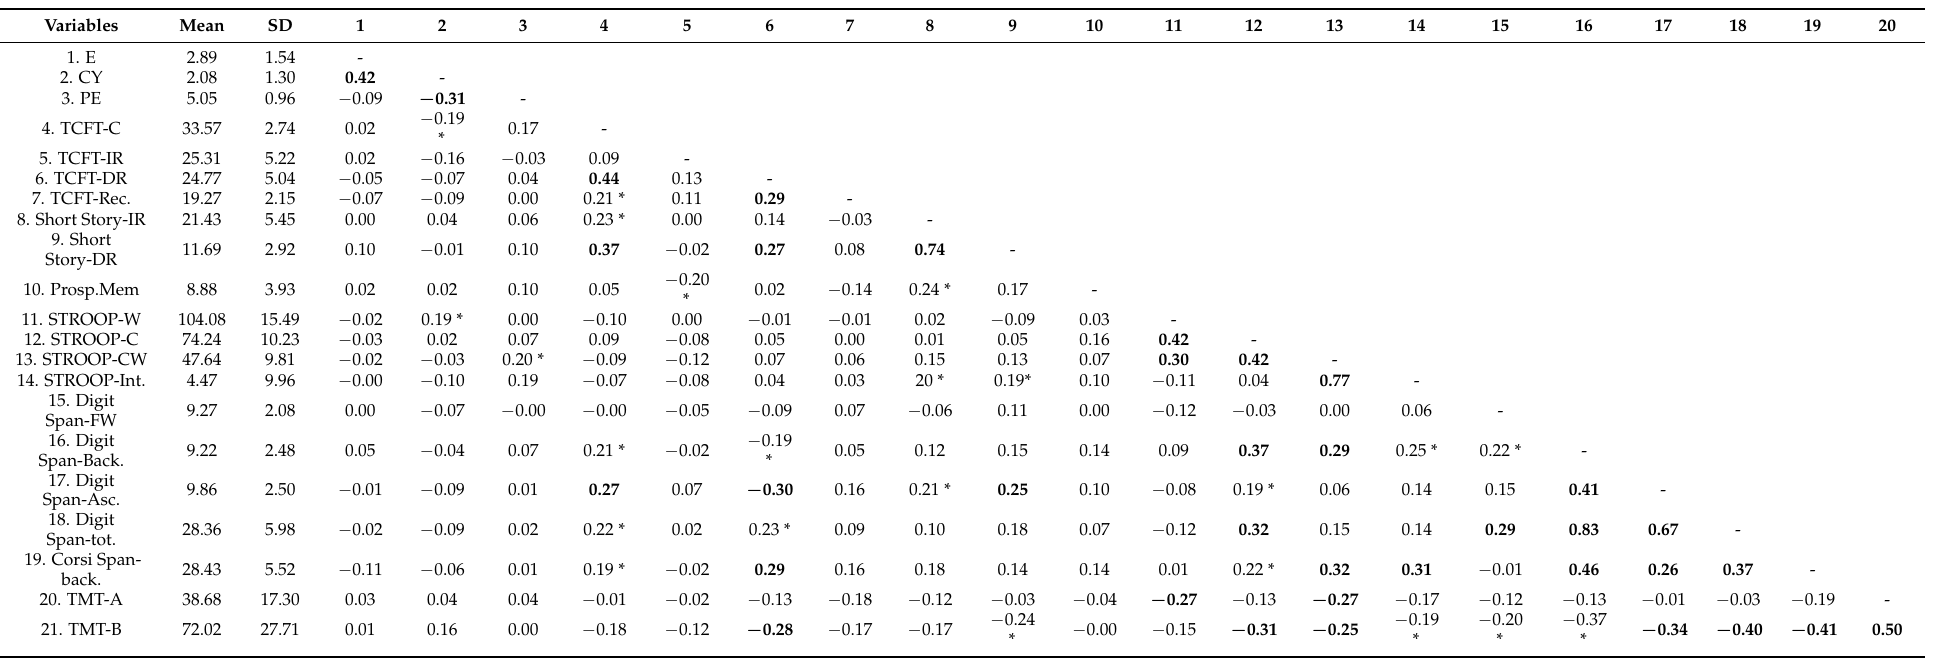
Table A4. Mean Scores, Standard Deviations (SD) and Correlation Coefficients among the three MBI Scheme